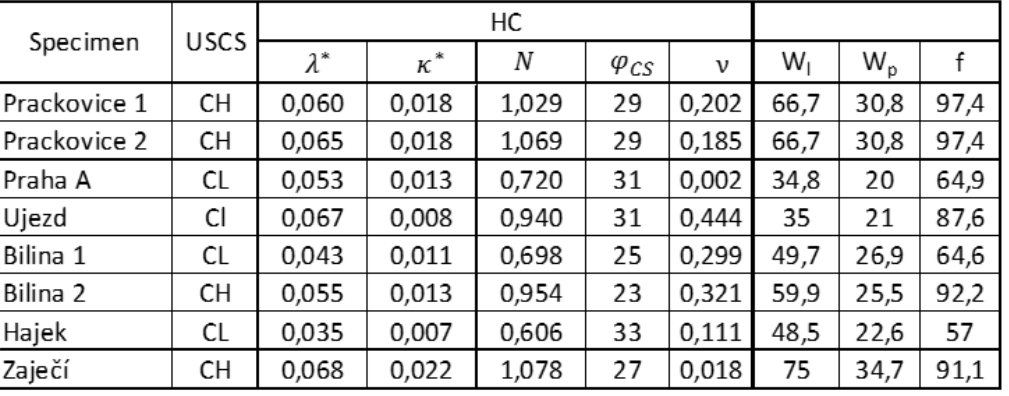
Table 1. Parameters of the HC model and selected parameters from index tests for reconstituted soil samples